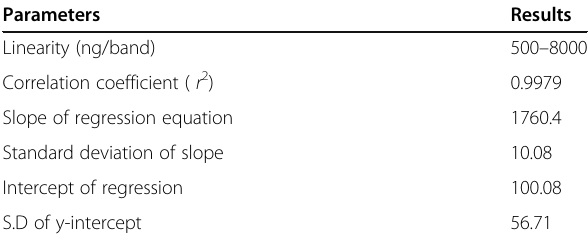
Table 1 Regression analysis of calibration